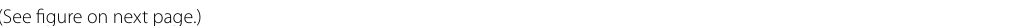
Fig. 2 Surgical findings and technique A 1—Bentall proximal anastomosis dehiscent, postoperative adherences to surrounding tissues, and “rocking valve,” 2—pseudoaneurysm in aortoventricular discontinuity. Coronary buttons attached to a fringe of previous graft, 3—proximal anastomosis deep in LVOT, 4—coronary buttons implanted. Distal composite graft anastomosis to an original graft fringe; B unendothelialized aortic mechanical prosthetic valve; and C